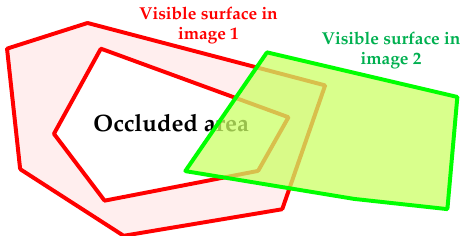
Figure 17. The intersection between two visible surfaces within two images where one of them includes an occluded area.